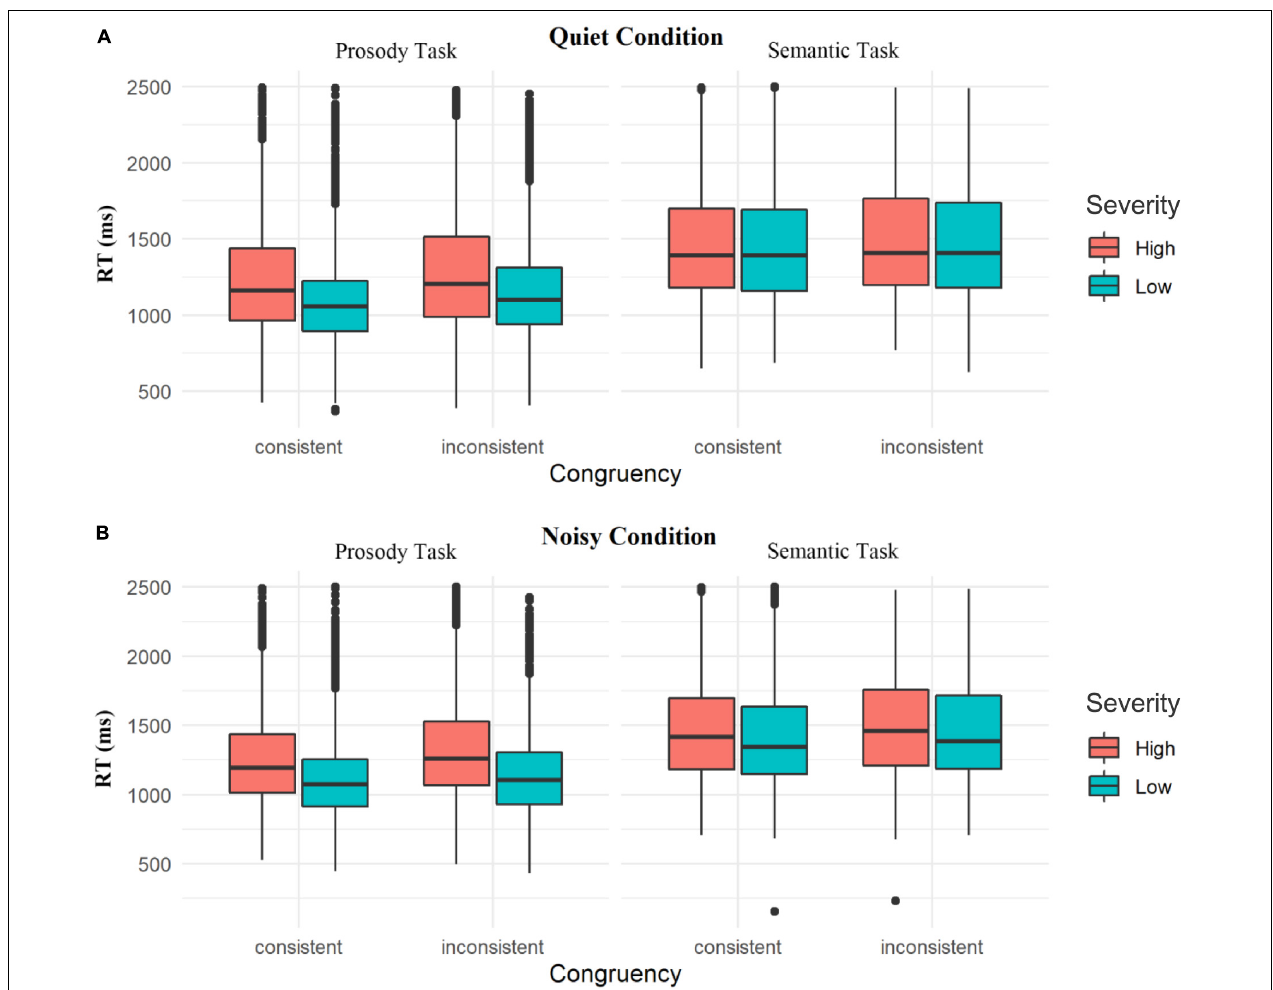
FIGURE 1 | Box plots of reaction time in participants with low and high trait depression across consistency (consistent vs. inconsistent) in prosody and semantic tasks in the quiet condition (A) and noisy condition (B)